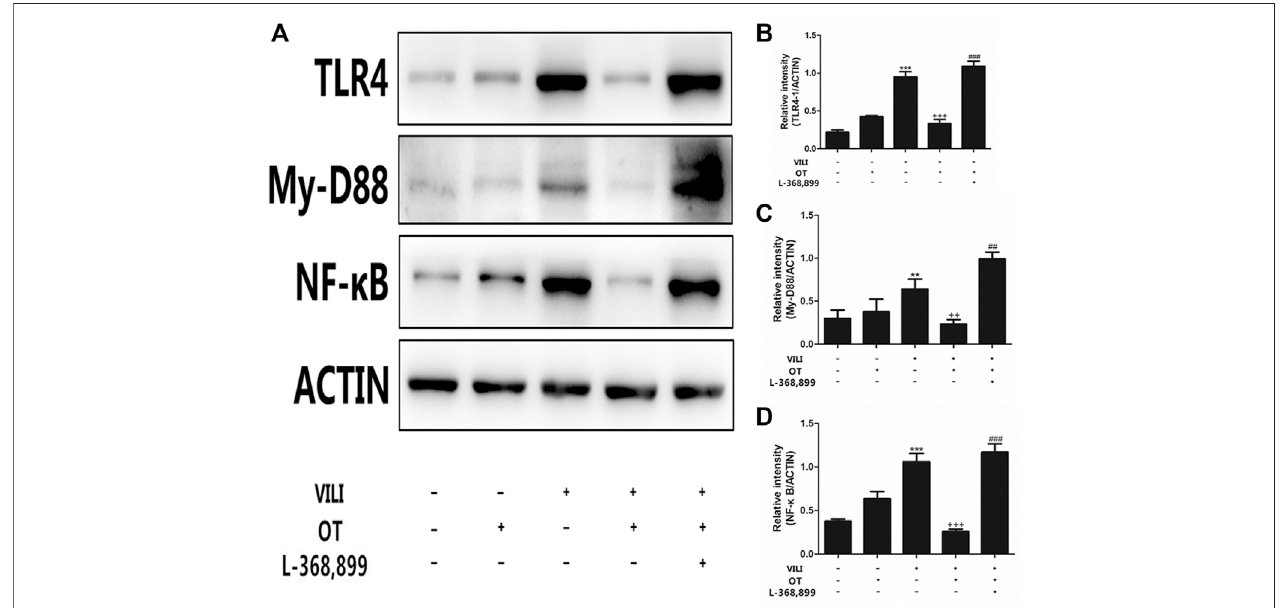
FIGURE6| EffectsofoxytocinontheexpressionofTLR4,My-D88,andNF- κ Bprotein.OTadministrationinhibitedTLR4-mediatedMy-D88/NF- κ Bactivationinthe mouseVILImodel.WesternblotwasperformedtoevaluatetheproteinexpressionofTLR4,My-D88,andNF- κ Binlungtissueexposedtomechanicalventilation (A) .The levelsofTLR4 (B) ,My-D88 (C) ,NF- κ B (D) proteinexpression werequanti fi edbymeasuring bandintensitiesand displayed asfoldincreaserelativetoACTIN. Thevalues presented are the means ± SD ( n (cid:2) 5). **p < 0.01 and *** p < 0.001 compared with the Control and Control + OT groups, ## p < 0.01 and p < 0.001 compared with the VILI group, and ++ p < 0.01 and +++ p < 0.001 compared with the OT + VILI group. OT, oxytocin; SD, standard deviation; VILI, ventilation-induced lung injury.